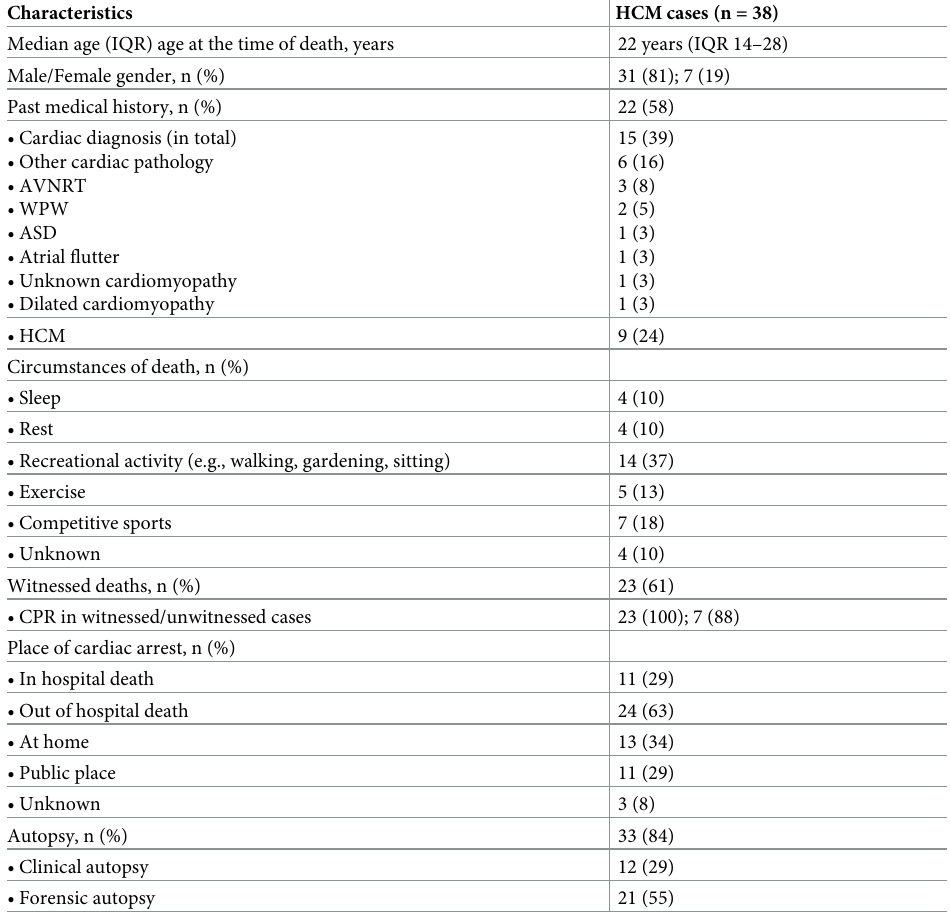
Table 1. Baseline and clinical characteristics of young HCM cases suffering from SCD, in Sweden 2000–2010.